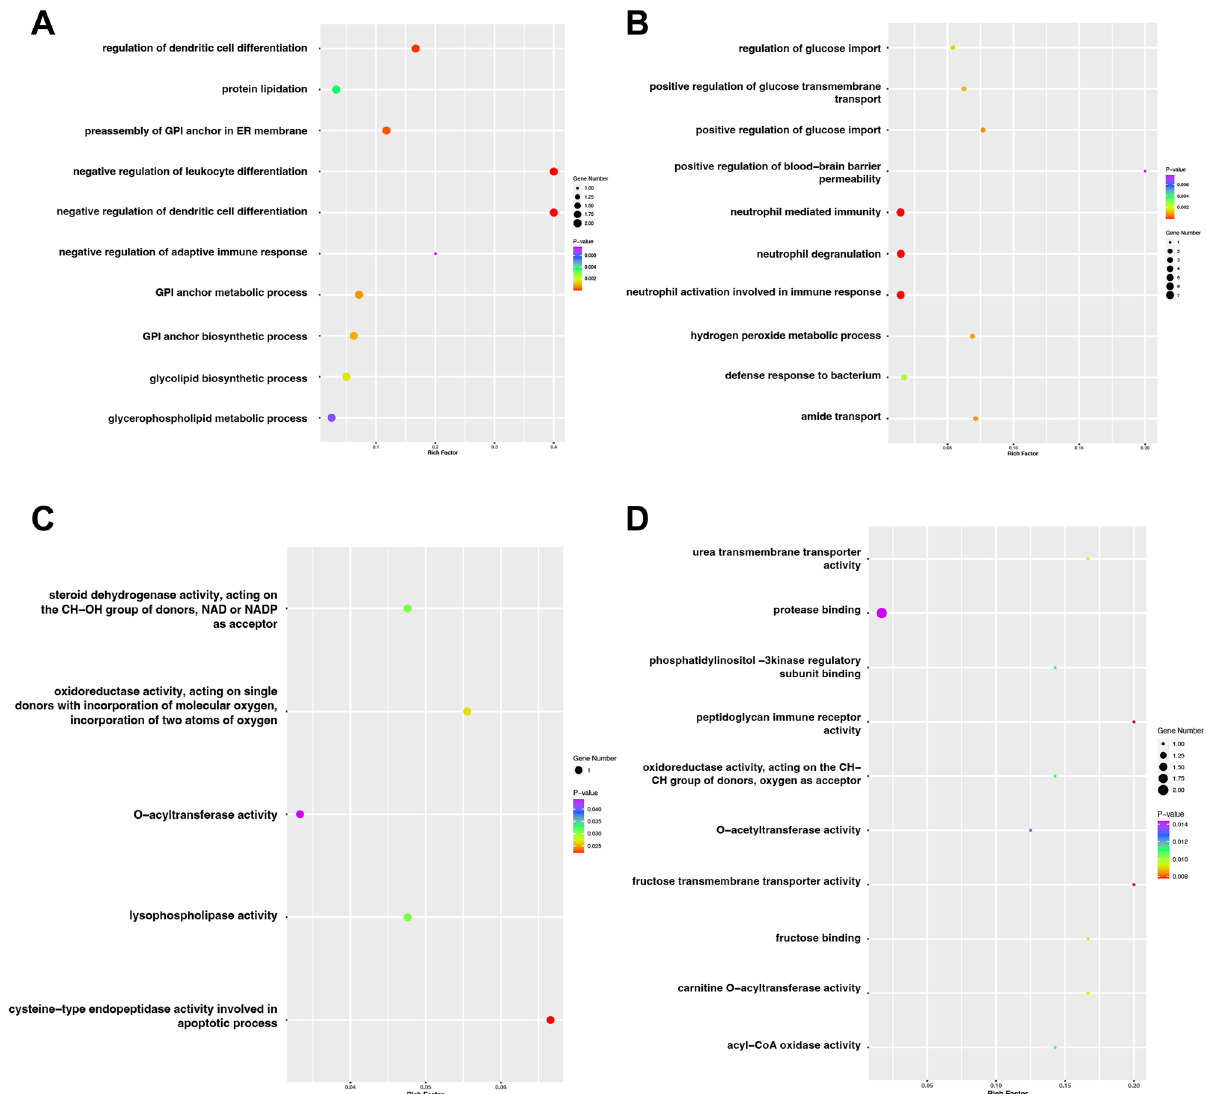
Figure 2. Gene ontology (GO) enrichment analysis. ( A ) Top 10 most significant changes in the GO biological process for up-regulated genes. ( B ) Top 10 most significant changes in the GO biological process for down- regulated genes. ( C ) Top 5 most significant changes in the GO molecular functions for up-regulated genes. ( D ) Top 10 most significant changes in the GO molecular functions for down-regulated